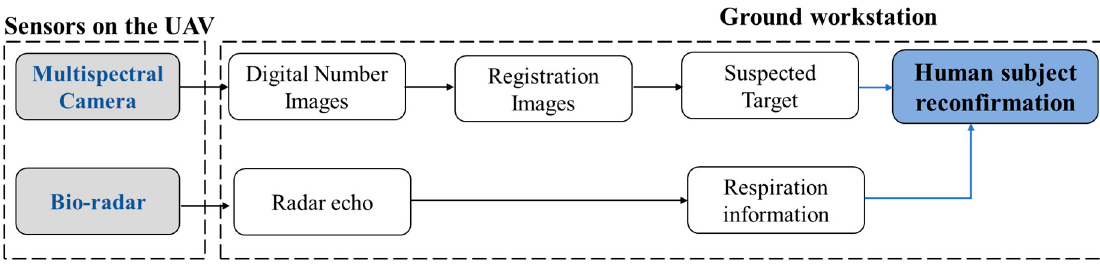
Figure 3. Suspected target detection and human nature re-identification based on UAV bio-modal information from multispectral camera and bio-radar. 2.1. The Optimized Multispectral Sensing Module The multispectral sensing (MSS) module on a cruising UAV at high altitude is used to acquire some specific spectral features of the target background for suspected human targets detection, which is referred to in stage 1 in Figure 3 during the entire search pro- cess. In our study, a few multispectral bans are specifically selected by observing and an- alyzing the sensitivity of different spectral bands to the environment and background. Consequently, some optimal bands would be picked out from numerous hyperspectral bands, which has the greatest ability to distinguish suspected human targets from the nat- ural environment with complex background situations. Since the relative reflectivity was defined as follows: 𝑅 (cid:3045)(cid:3032)(cid:3039)(cid:3028)(cid:3047)(cid:3036)(cid:3049)(cid:3032) = 𝐿 (cid:3046)(cid:3048)(cid:3029)(cid:3037)(cid:3032)(cid:3030)(cid:3047) 𝐿 (cid:3029)(cid:3042)(cid:3028)(cid:3045)(cid:3031) • 𝑅 (cid:3029)(cid:3042)(cid:3028)(cid:3045)(cid:3031) (1) where 𝑅 (cid:3045)(cid:3032)(cid:3039)(cid:3028)(cid:3047)(cid:3036)(cid:3049)(cid:3032) and 𝑅 (cid:3029)(cid:3042)(cid:3028)(cid:3045)(cid:3031) are the reflectivity of subject and reference board, 𝐿 (cid:3046)(cid:3048)(cid:3029)(cid:3037)(cid:3032)(cid:3030)(cid:3047) and 𝐿 (cid:3029)(cid:3042)(cid:3028)(cid:3045)(cid:3031) are the spectral radiance of subject and reference board. According to the spec- tral curve, we could pick out corresponding characteristic points which are promising to distinguish green clothes from grassland. In our study, a large number of preliminary measurement experiments were carried out to obtain the wavelength-relative reflectivity curve for green vegetation (to simulate